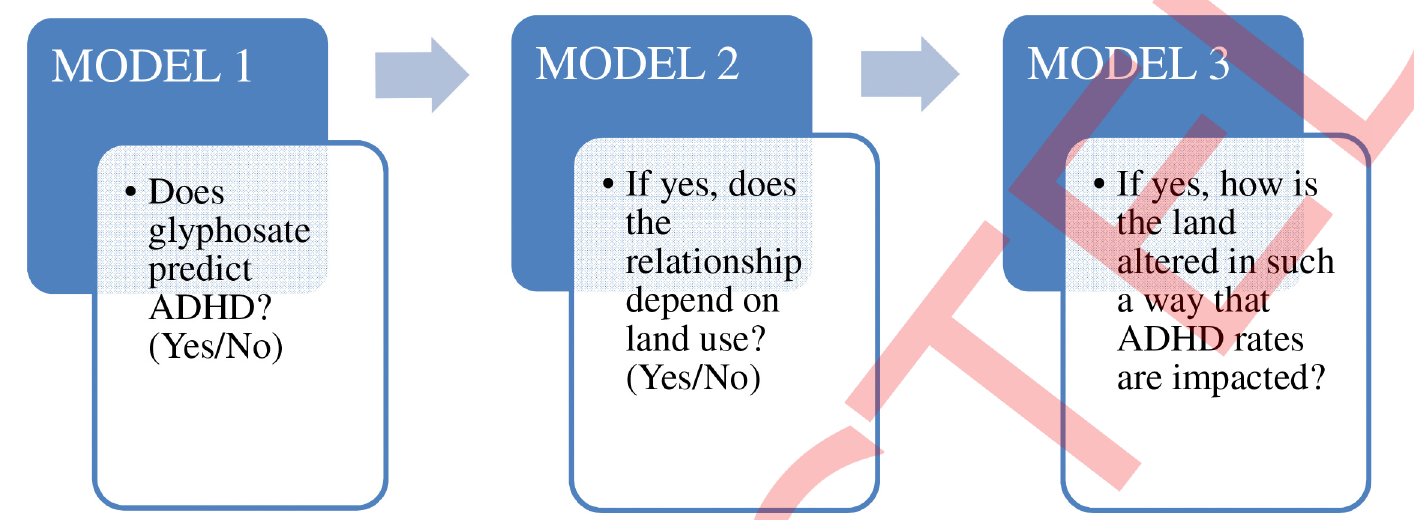
Fig 1. The empirical schematic for studying the association between glyphosate use and ADHD.